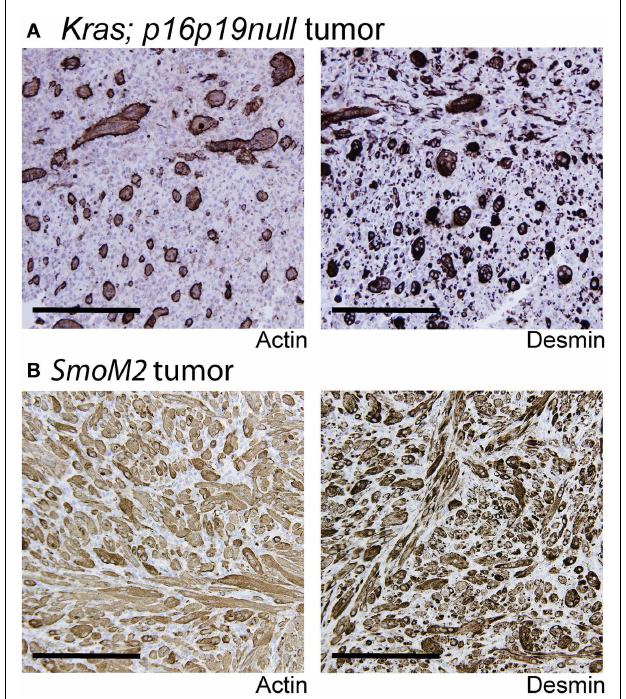
FIGURE 1 |Terminal myogenic differentiation in Kras; p16p19 null and SmoM2 mouse tumors . (A) Subsets of Kras; p16p19 null tumors cells express terminal muscle differentiation markers, actin and desmin. (B) The majority of SmoM2 tumor cells express actin and desmin. Images were taken at 20 × (scale bars indicate 100 µ